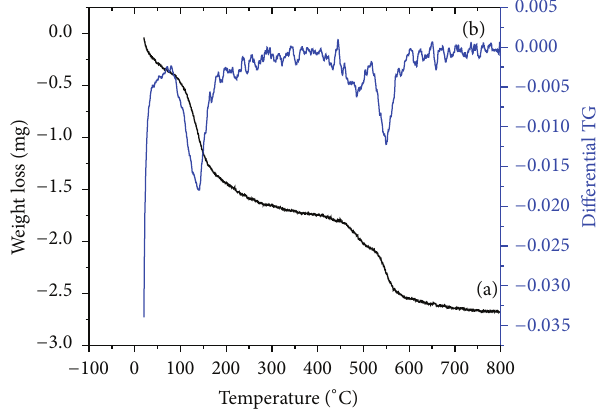
Figure 11: (a) TGA thermograms of urea. (b) Differential plot of urea fertilizer.